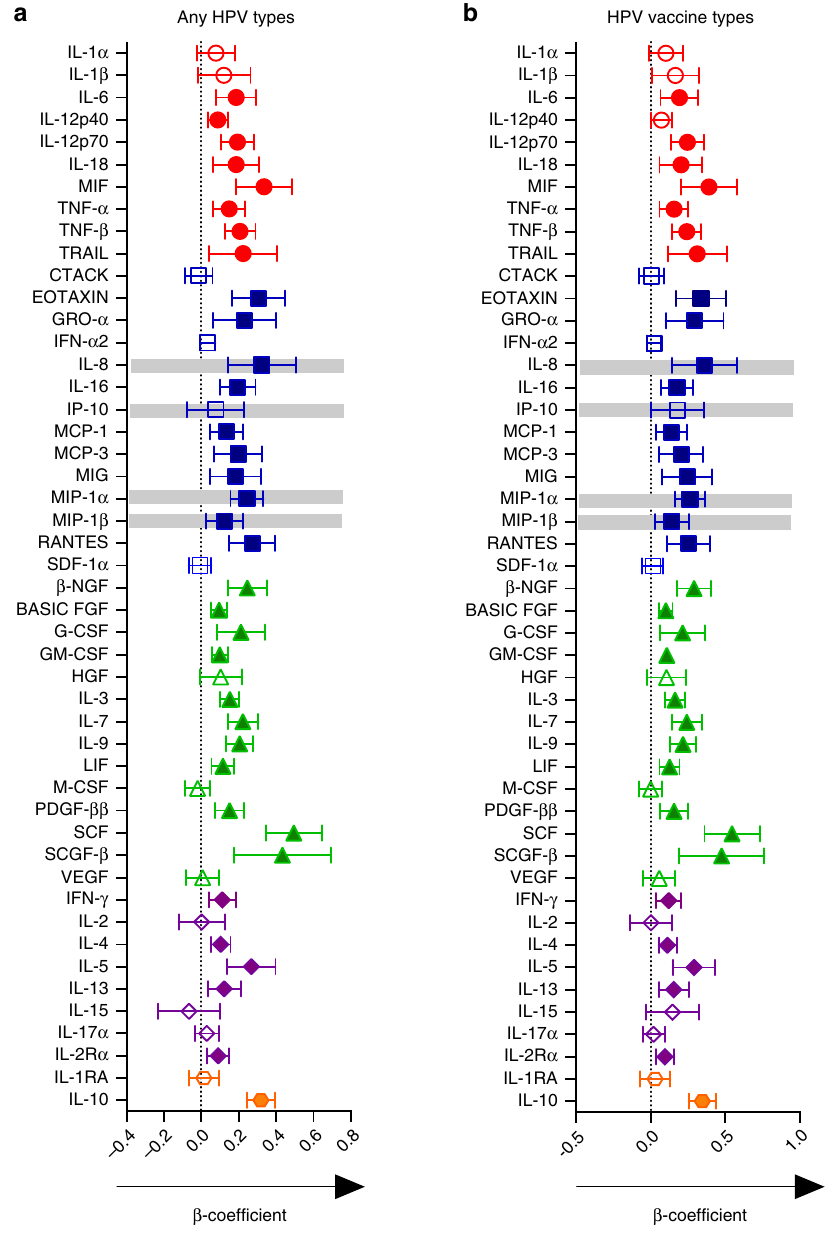
Fig. 4 Association between prevalent HPV infection and genital cytokines. Plots depict the mean differences in genital cytokine concentrations between women with detectable HPV DNA and those without ( N = 740; Fig. 4a), and speci fi cally in women infected with any of the nine preventable HPV vaccine types compared to women with no evidence of genital HPV DNA ( N = 472; Fig. 4b). Individual associations are shown between HPV status and pro- in fl ammatory cytokines (red), chemokines (blue), growth/hematopoietic factors (green), adaptive response cytokines (purple), and regulatory cytokines (orange), with error bars depicting 95% con fi dence intervals. The models test the hypothesis that the mean cytokine levels in comparator groups are equal i.e. β = 0. The dotted line at β = 0 distinguishes higher (to the right of the line) from lower (to the left of the line) mean cytokine differences in the respective categories relative to the HPV negative group. Gray shadings represent genital cytokines previously associated with HIV risk in this cohort: IP- 10, IL-8, MIP-1 α , and MIP-1 β . Filled shapes represent signi fi cant associations after false discovery rate (FDR) adjustment using a threshold of 0.05 in multivariable models controlling for baseline treatment group, age, age of sexual debut, number of sexual partners number of sex acts (past 30 days), presence of STI symptoms, HSV-2 status, condom use, marital status, and whether women were living with regular